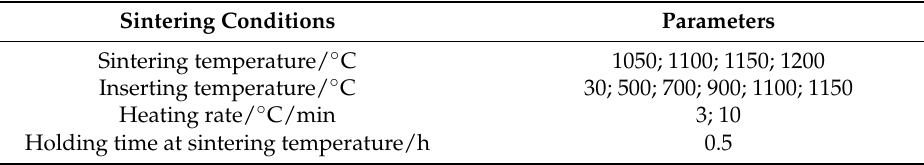
Figure 1. Schematic diagram of RCG coating preparation process. Table 1. Sintering condition